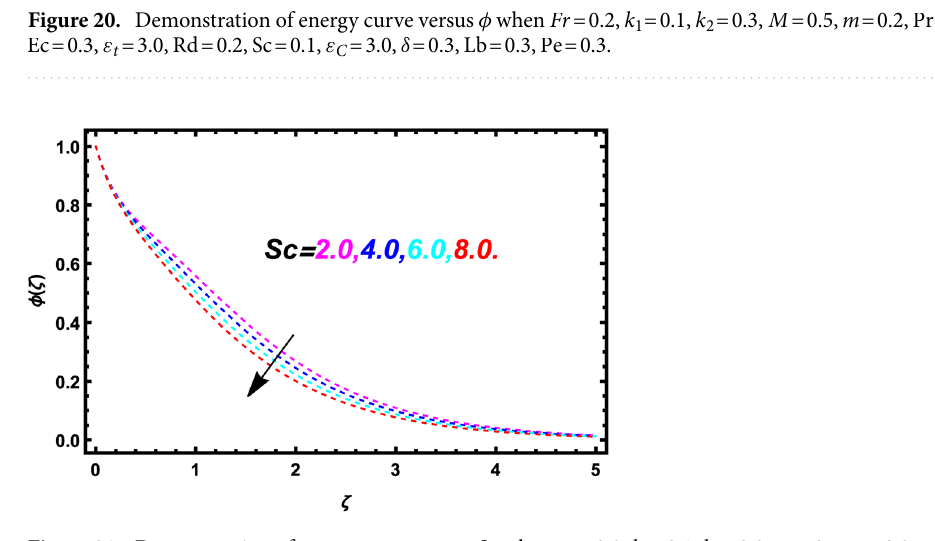
Figure 21. Demonstration of energy curve versus Sc when Fr = 0.2, k 1 = 0.1, k 2 = 0.3, M = 0.5, m = 0.2, Pr = 5.3, φ = 0.01, Ec = 0.3, ε t = 3.0, Rd = 0.2, ε C = 3.0, δ = 0.3, Lb = 0.3, Pe =